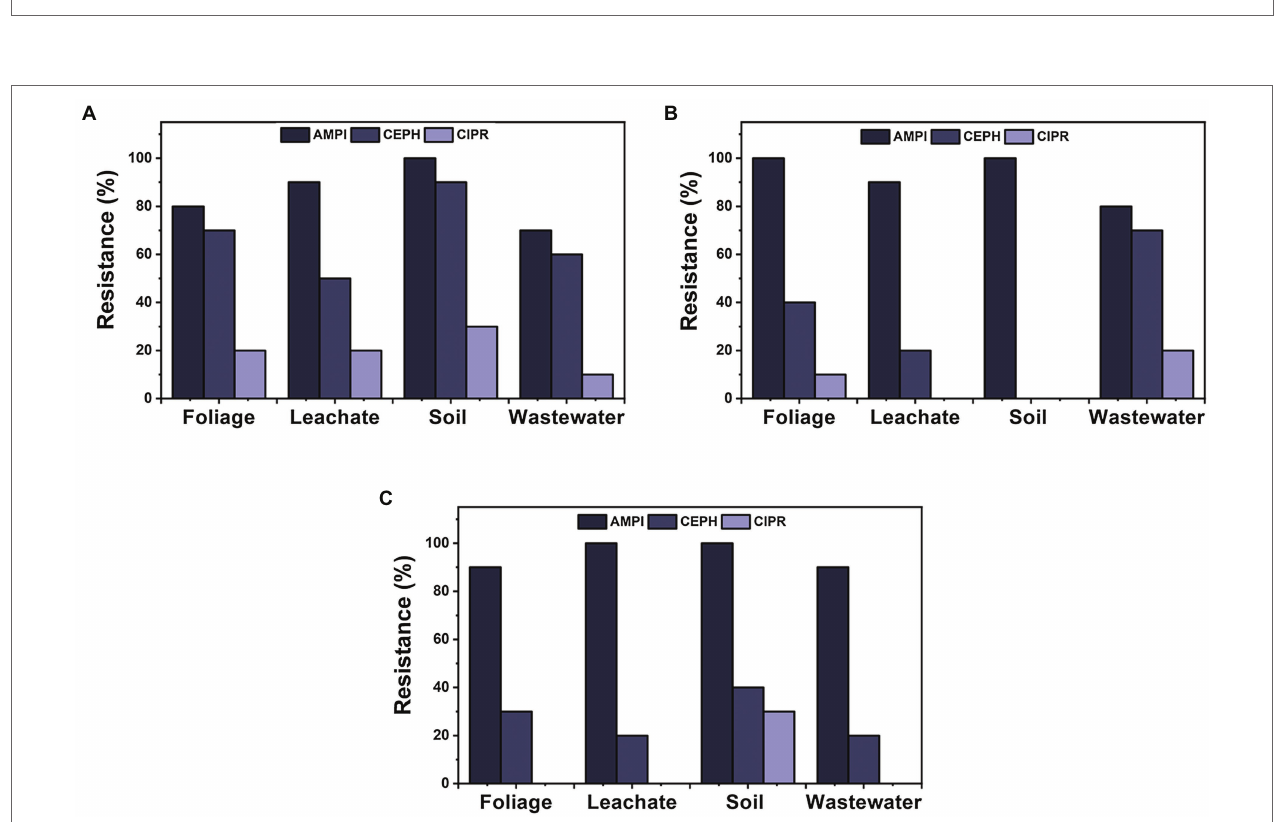
FIGURE 6 | Comparison of ARB for three antibiotics that displayed the highest prevalence of resistance (AMPI, ampicillin; CEPH, cephalothin; and CIPR, ciprofloxacin) among materials over sampling times during cultivation: (A) day 0, (B) day 7, and (C) day